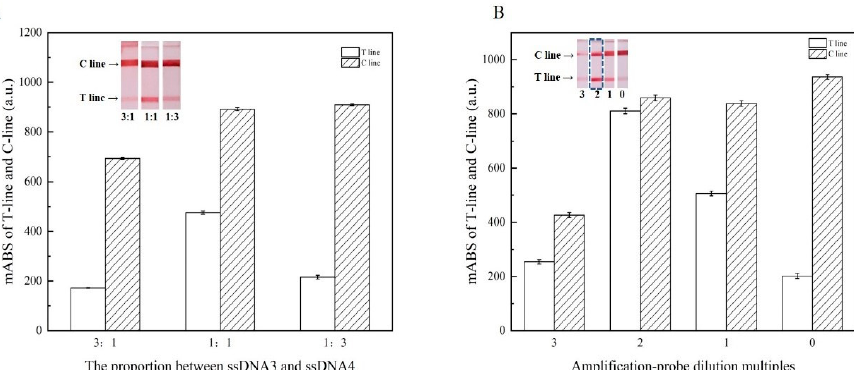
Figure 4. Optimization of the analysis parameters: Effect of proportion between ssDNA3 and ssDNA4 of amplification probe on the signal of lateral flow strips ( A ); effect of amplification probe dilution multiples on the signal of lateral flow strips ( B ). Inset: photographs of the lateral flow assay results of different parameters. Data represent mean ± SD ( n = 3). Error bars indicate the standard errors of three independent experiments.